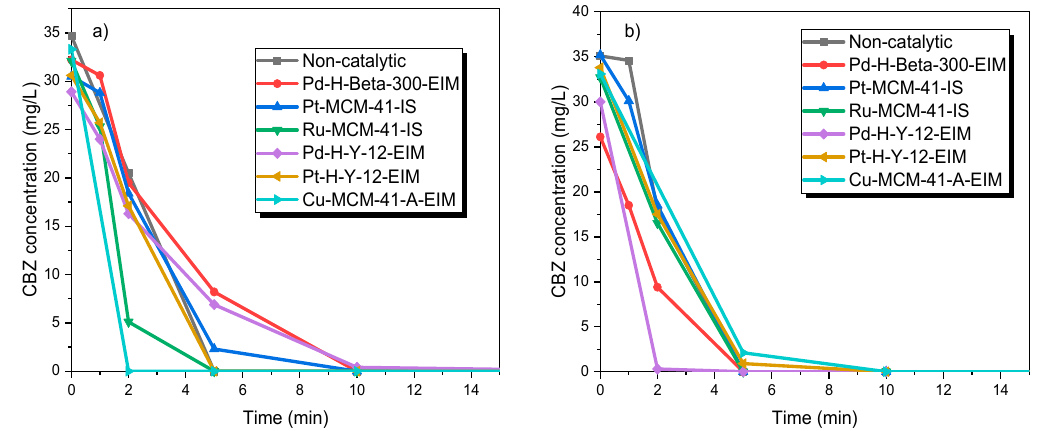
Figure 5. CBZ degradation by ozonation and ozonation combined with catalysis. C CBZ = 35 mg/L, gas flow rate = 110 mL/min, stirring speed = 900 rpm, C O3, g = 21 mg/L, C catalysts = 0.5 g/L. ( a ) T = 20 °C and ( b ) T = 50 °C.